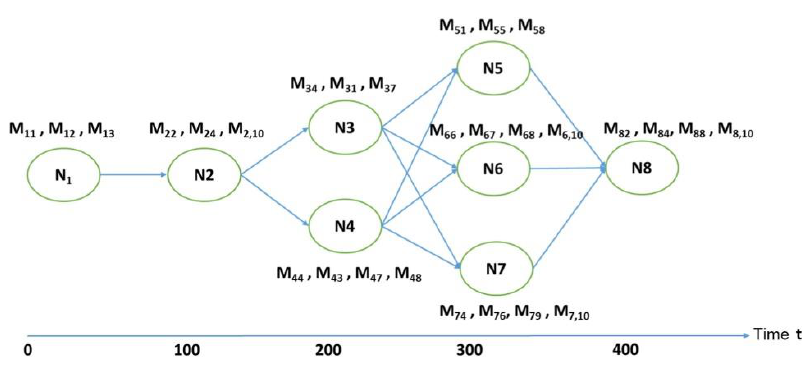
Figure 3. Tasks, candidates, and sequence of tasks.